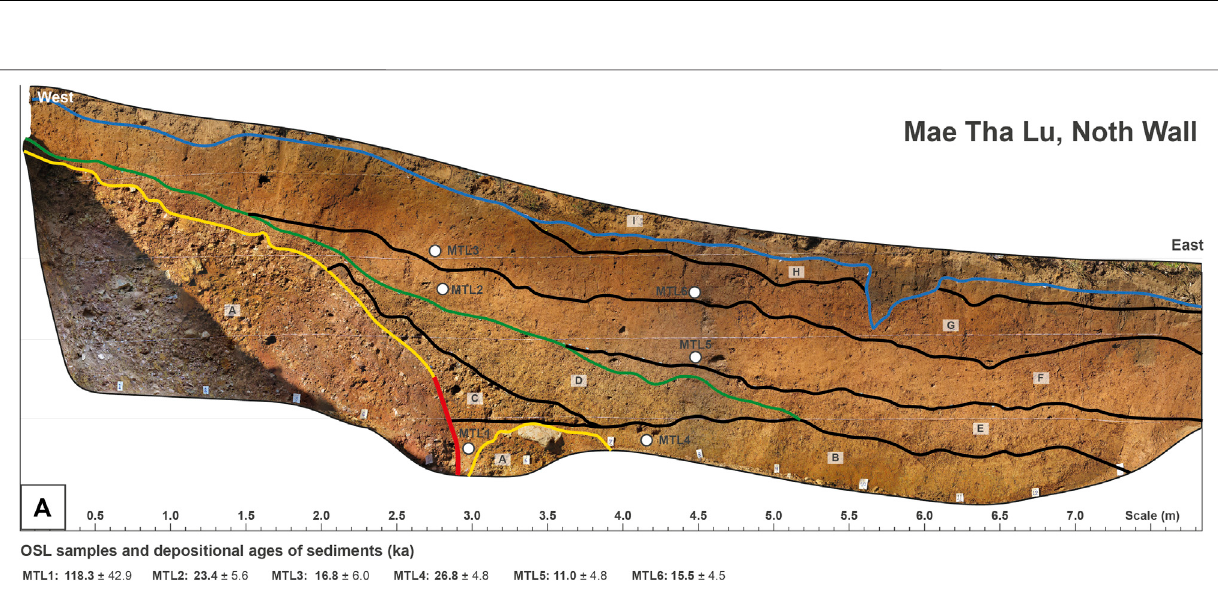
Frontiers in Earth Science |